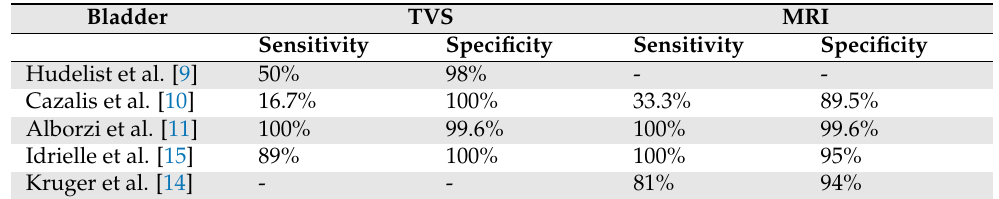
Table 5. The diagnostic accuracy of TVS and MRI in urinary bladder DE (as reported in different studies).